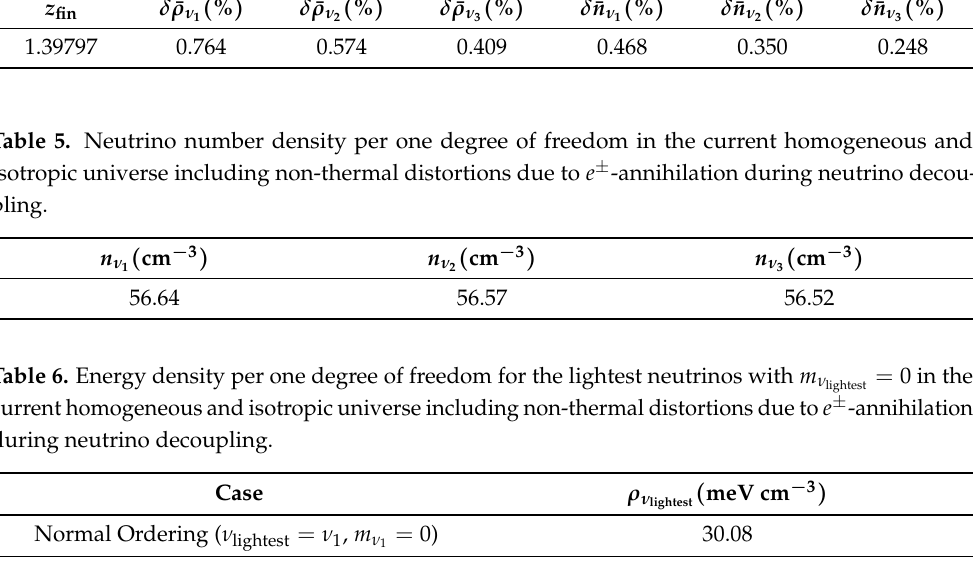
Table 4. Final values of the distortions of “relativistic” energy densities δ ¯ ρ ν